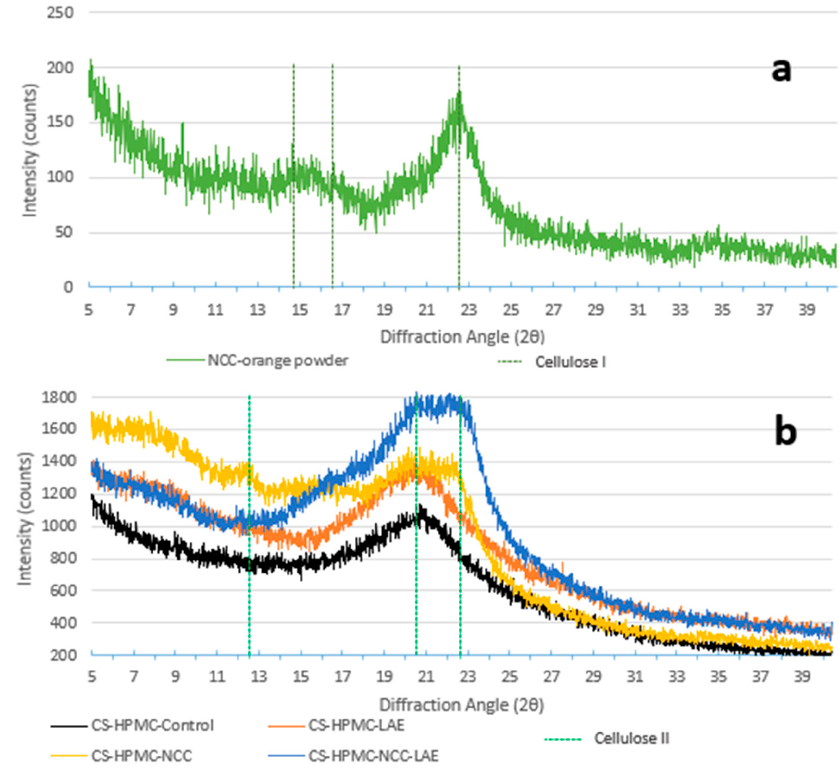
Figure 3. XRD patterns’ signals of ( a ) CNCs from orange peel, and ( b ) films with and without CNCs. Table 1. Crystallinity index of the films and CNCs of orange peel was calculated as described in Section 2.6.